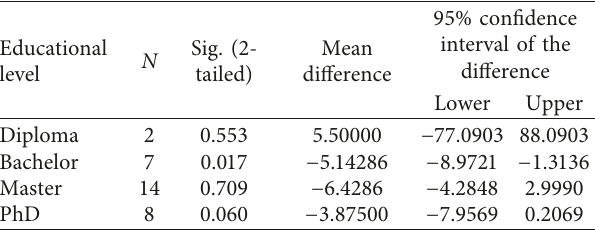
Table 9: Statistic and one-sample t -test for depersonalization with reference to educational level.